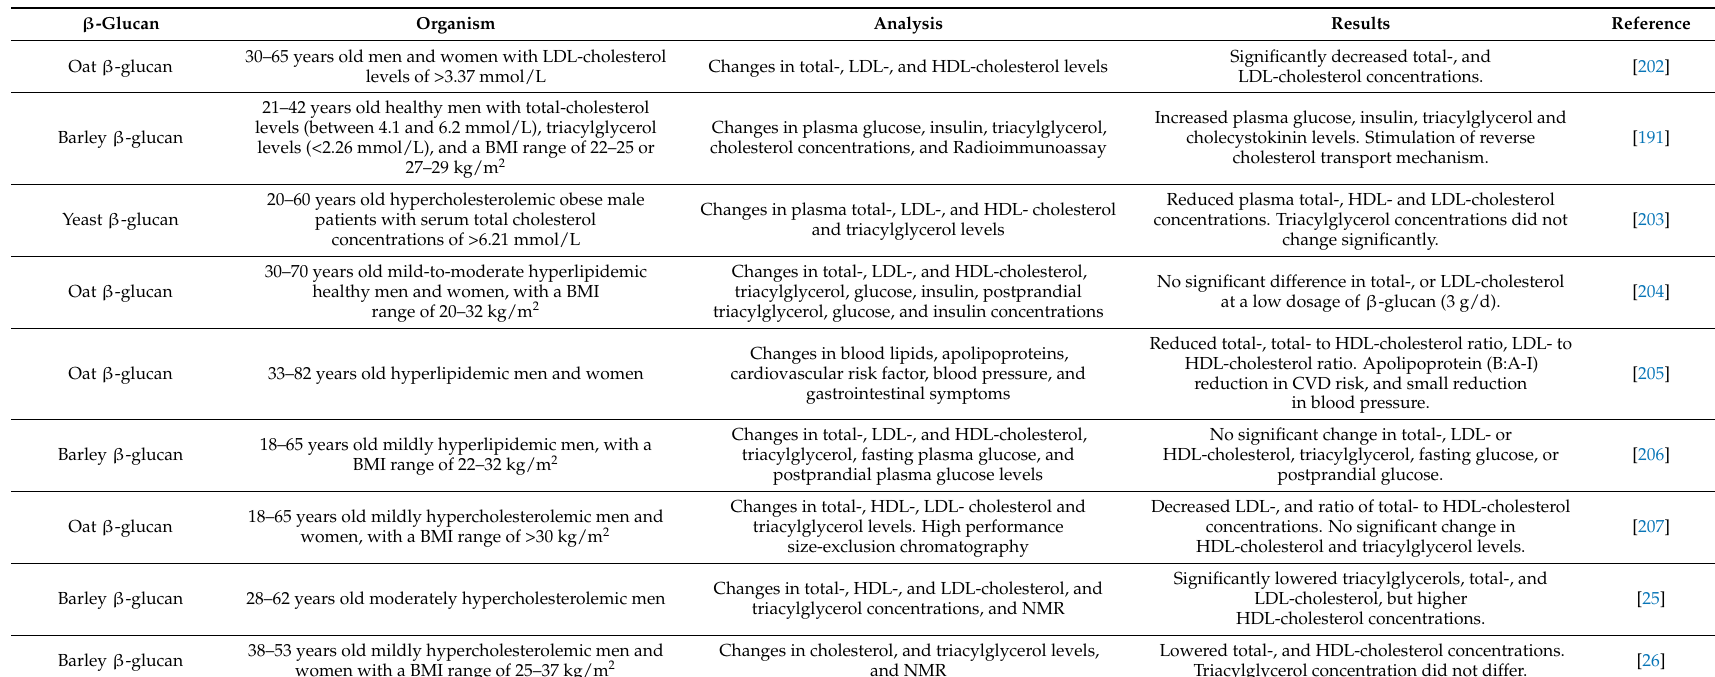
Table 14. Cholesterol and blood lowering effects of β -glucans—human